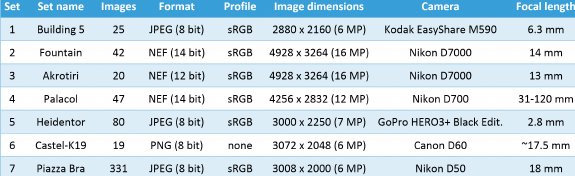
Table 2. Characteristics of the seven different image collections used in this